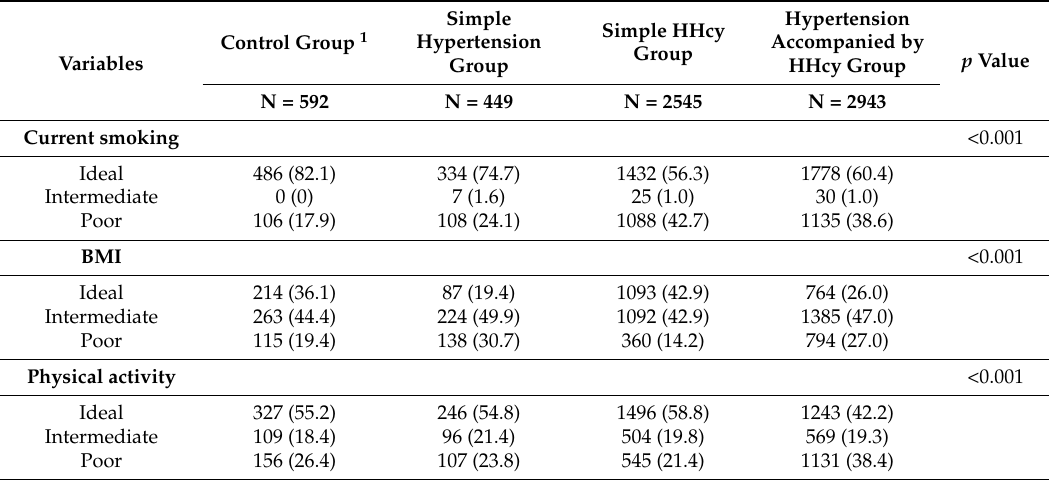
Table 2. The distribution of six CVH metrics according to BP status and Hcy